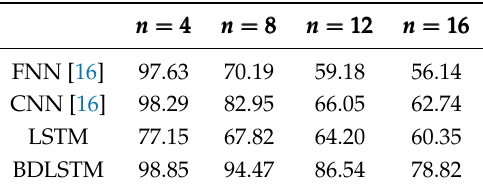
Table 1. Accuracy performance comparison.